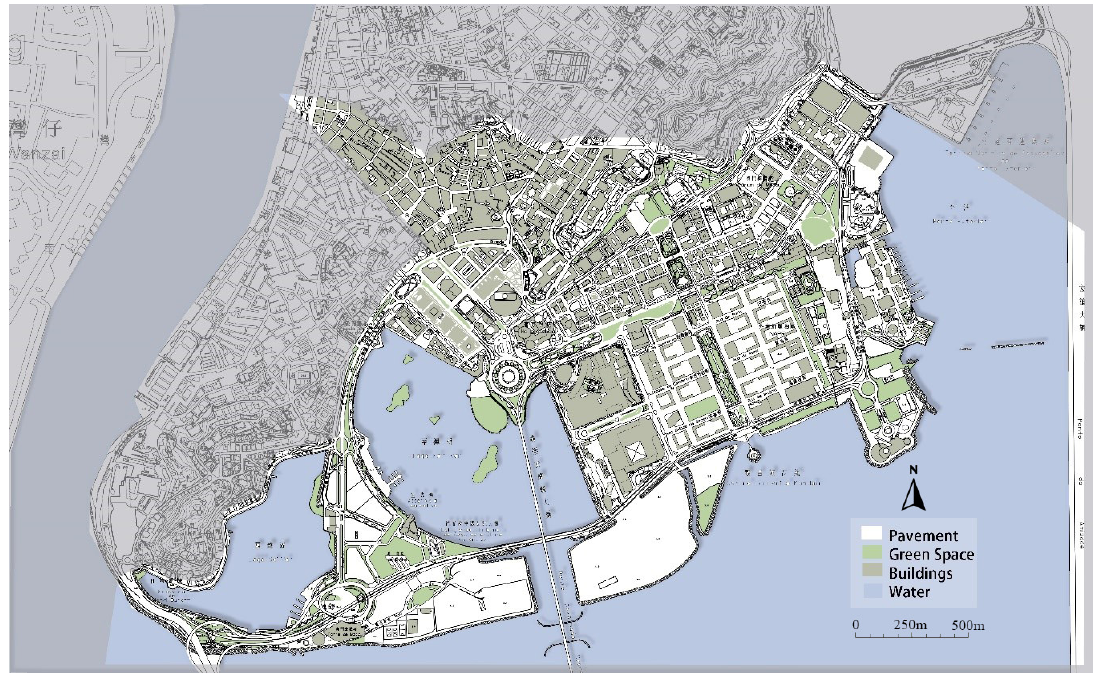
Figure 8. Map of the existing surface types of Cathedral Parish.